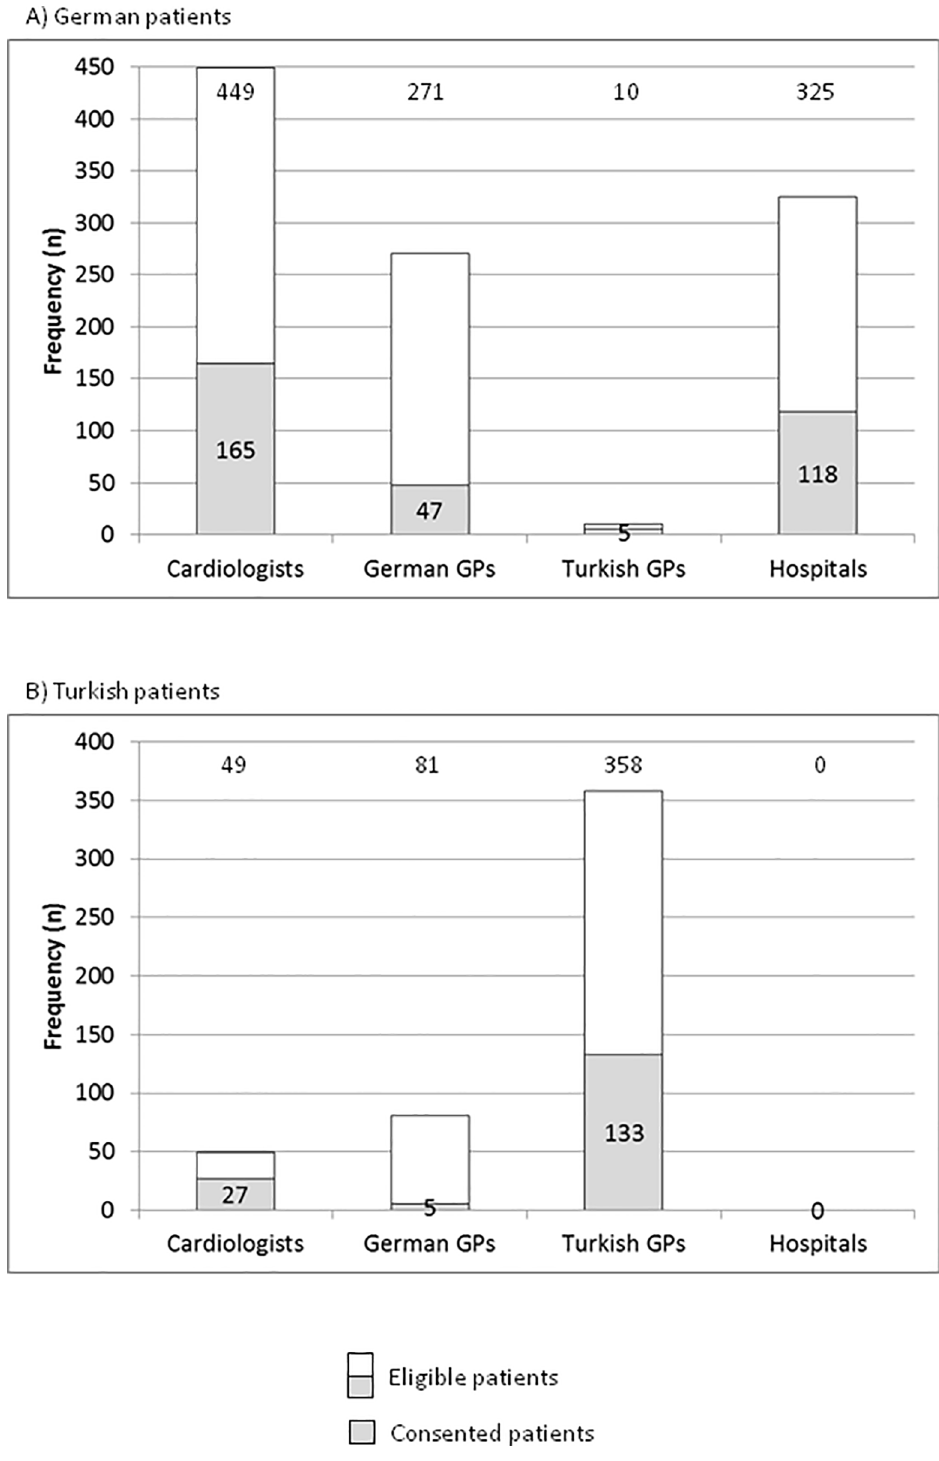
Fig 3. Frequency of German (A) and Turkish (B) eligibleand consentedpatients by recruitinginstitutions.